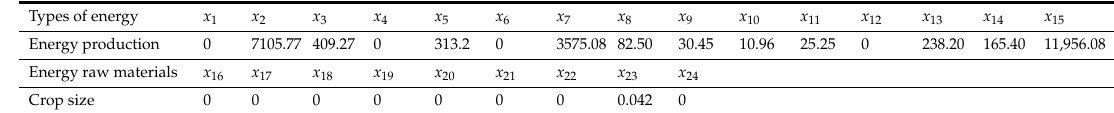
Table 9. The results of optimization